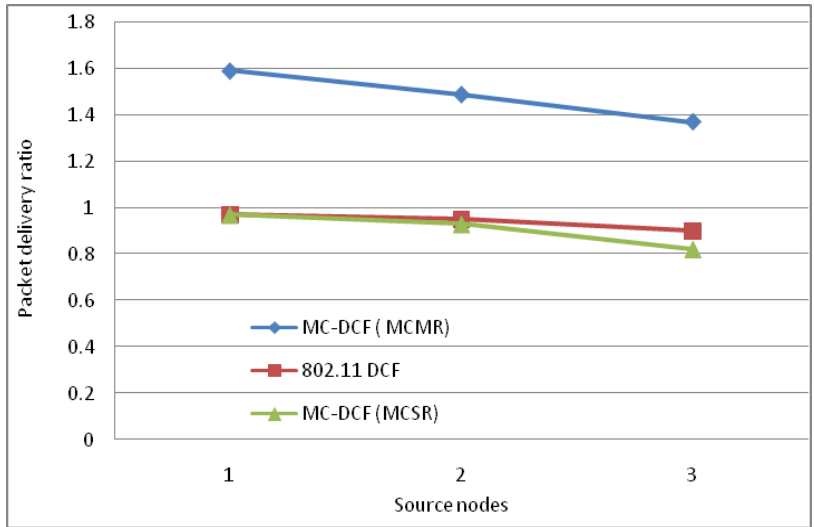
Figure 8. Delivery ratio impact with multichannel multi-radios communication at sink node.